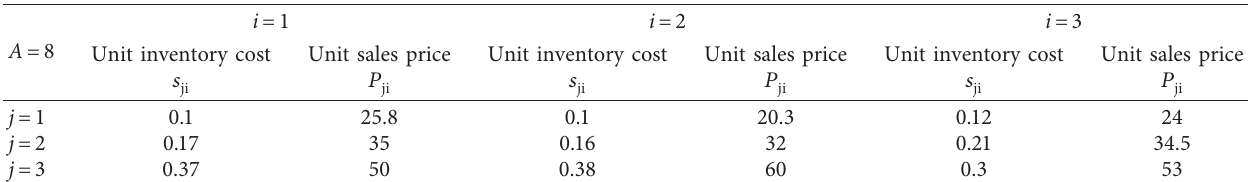
Table 3: Data table of